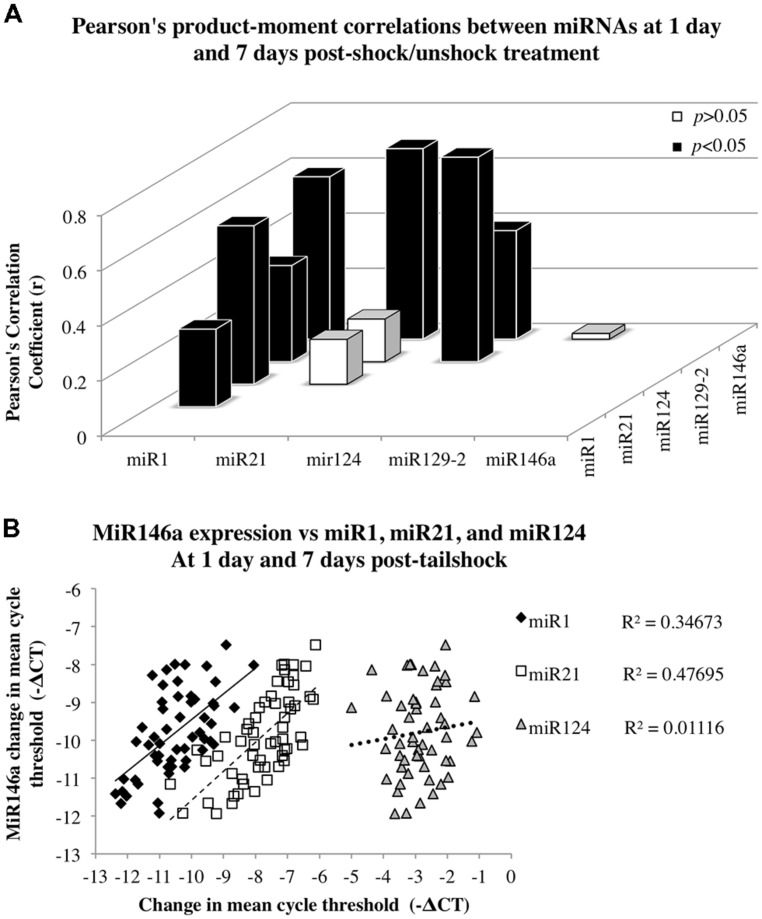
Correlation analyses to assess the relationship between miR146a miRNA expression and expression of miR1, miR21, and miR124 following SCI. Data for dorsal and ventral spinal cord and for day 1 and 7 post-shock were combined for analysis. (A) The x-axis and z-axis represent the miRNAs of interest, and the y-axis depicts the magnitude of the Pearson’s product–moment correlation coefficient, r, between the corresponding miRNAs indicated on the x- and z-axes. Pearson’s correlations indicated seven statistically significant relationships (p < 0.05; black bars) and three non-significant relationships (p> 0.05; white bars). (B) The x-axis represents the mean difference in cycle threshold change (-ΔCT) between miRNA expression at both dorsal and ventral spinal cord and at 1 and 7 days following tailshock treatment and U6 controls, and the y-axis depicts the mean difference in cycle threshold change (-ΔCT) between miR146a expression in dorsal and ventral spinal cord and at both 1 and 7 days following tailshock treatment and U6 controls. Pearson’s correlations indicated a significant correlation between miR1 (black diamonds), miR21 (white squares), and miR124 (gray triangles), and miR146a (Pearson’s r = 0.59, P < 0.001, Pearson’s r = 0.69, P < 0.001, and Pearson’s r = 0.39, P < 0.005, respectively). Data are represented as the mean change in cycle threshold of miRNA expression relative to U6 controls (-ΔCT = CTU6 - CTmiRNA).